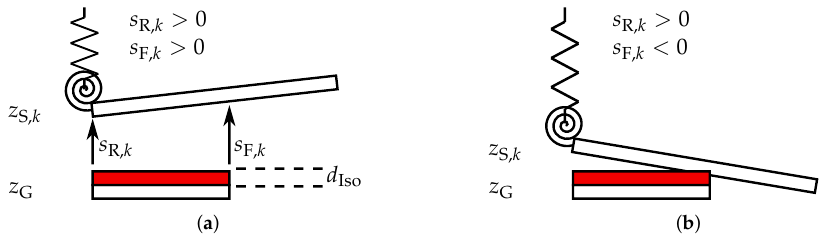
Figure 3. Definition of the overlap between the ground plate and the beam. ( a ) A virtual insulation layer with thickness d Iso (red) is used for numerical stability, preventing a short circuit within the simulation in case of an overlap. Since no contact occurs, the distances s R, k and s F, k are positive. ( b ) The front part of the beam is in contact with the ground plate, resulting in s F, k <